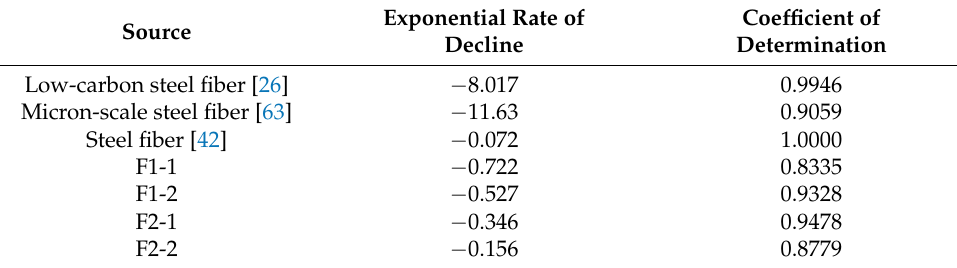
Figure 10. Comparison of decreasing surface electrical resistance with increasing volumetric percentage of steel fiber in numerical and experimental experiments. Table 4. Formulation of experimental and numerical results